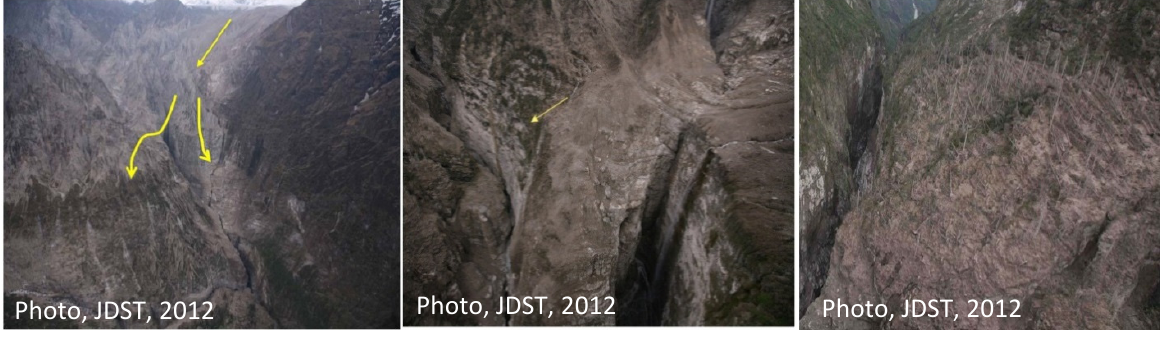
Figure 9. Northern part of Pokhara valley, Seti Gorge (Photos were taken by the Japanese Disaster Survey Team, 2012).